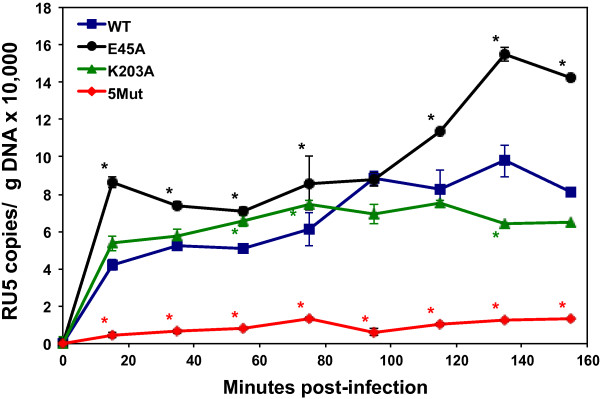
Initiation of reverse transcription was more rapid in E45A HIV-1 compared to WT, K203A, and 5Mut HIV-1. Early viral reverse transcripts (RU5) were measured by qPCR from TZM-bl cells infected with equal p24 levels of WT, E45A, K203A, and 5Mut HIV-1. Data represent the mean ± SEM of duplicates and are normalized for μg of total isolated DNA. Asterisks denote statistically significant p values (p < 0.05) between WT and each mutant at each time point. The graph is representative of 2 independent experiments.